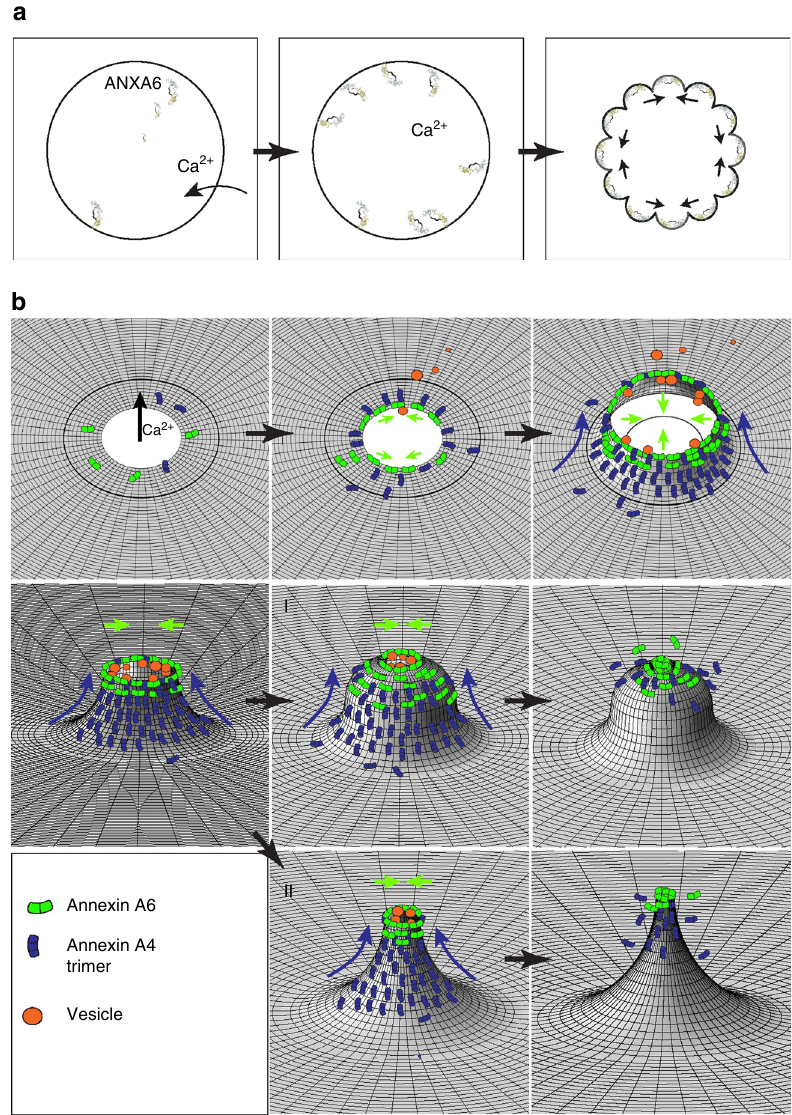
Fig. 7 Proposed model for plasma membrane repair initiated by ANXA4 and ANXA6. a Binding of ANXA6 to wound edges induces local in-plane folding, which contracts the hole edges. b In uninjured cells, ANXA6 and ANXA4 are distributed uniformly as monomers in the cytoplasm. Upon local plasma membrane injury, Ca 2+ in fl ux results in recruitment of ANXA6 and ANXA4 to the membrane wound edges. ANXA6 initiates constriction of hole edges and may also cross-bridge patch vesicles translocated to the injury site. ANXA4 self-assembles into trimers that induce local out-of-plane curvature. The combined forces of constriction and curvature accelerate wound closure eventually leading to fusion of membrane edges. Vesicles recruited and fused to the wound edges contribute to repair by reducing wound size. The curvature structure triggered by ANXA4 can take several shapes including I round or II funnel-shaped or a more fl at structure (not shown). Subsequent repair steps include local actin polymerization to fully restore the membrane after